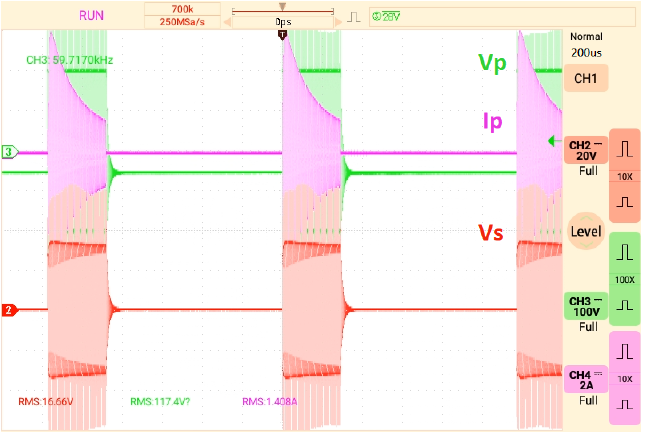
Figure 18. LLC resonant converter DOM experimental results V o = 29.4 V, I o < 2 A, f sw = 218 kHz, 25% DOM duty.